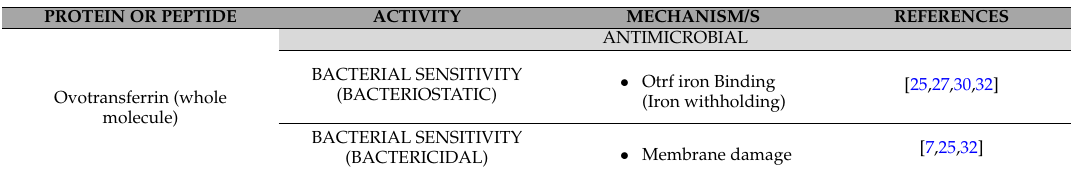
Table 1. Physiological and pharmacological activities of Ovotransferrin (Otrf) and its peptides identified